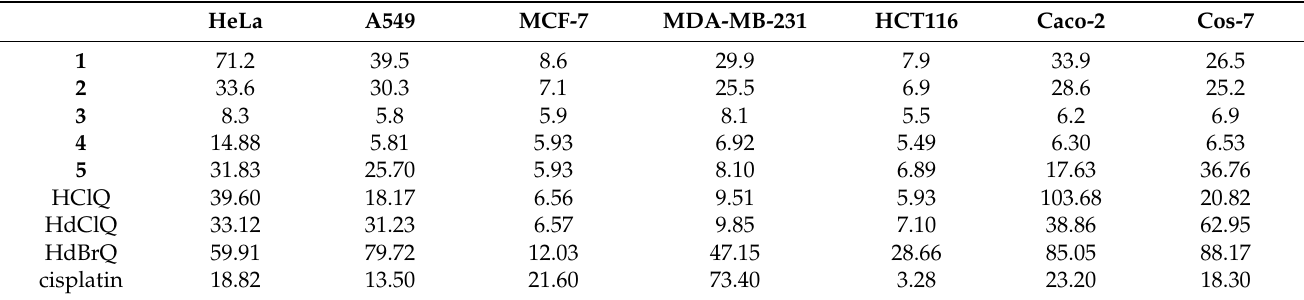
Table 9. IC 50 values [ µ M] for complexes 1 – 5 , corresponding ligands and cisplatin in the various cell